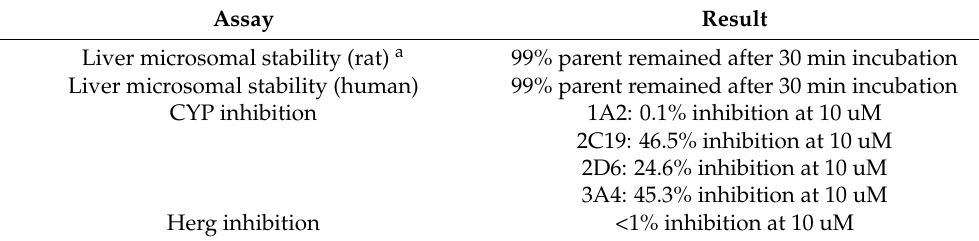
Table 5. Liver microsomal stability, CYP, and Herg inhibition of compound 18i .